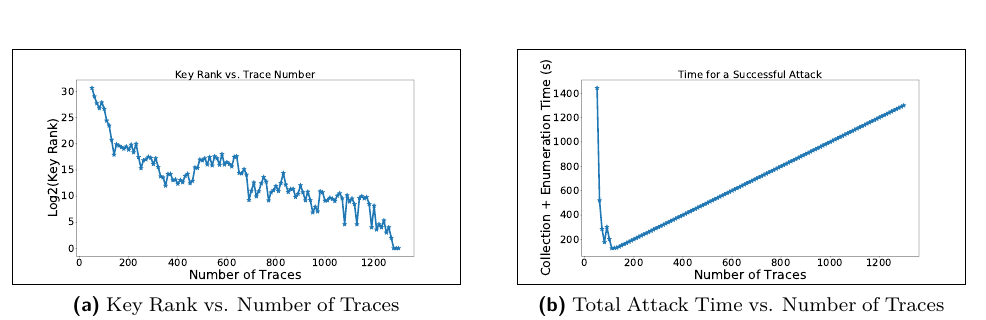
Figure 12: Analysis of key enumeration, for 5000 · 500 template traces and 2000 · 500 attack traces at a distance of 10 cm in a home environment.